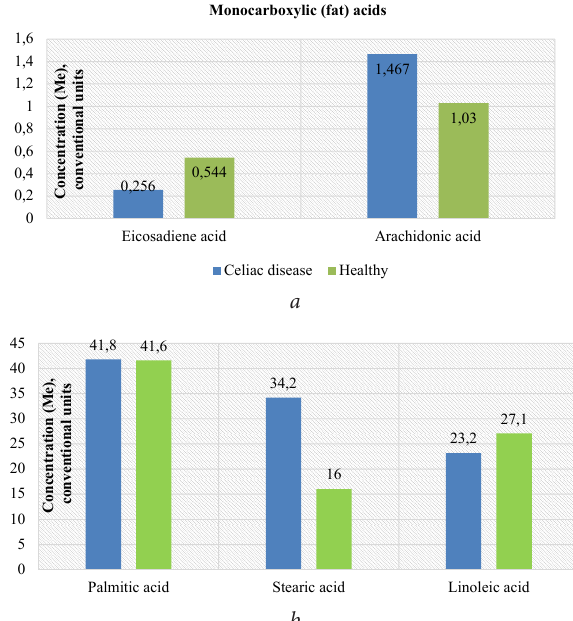
Fig. 2. The concentration of monocarboxylic acids in the blood serum of patients with celiac disease and healthy volunteers: a – the concentration of eicosadienoic and arachidonic acids; b – the concentration of palmitic, stearic and linoleic